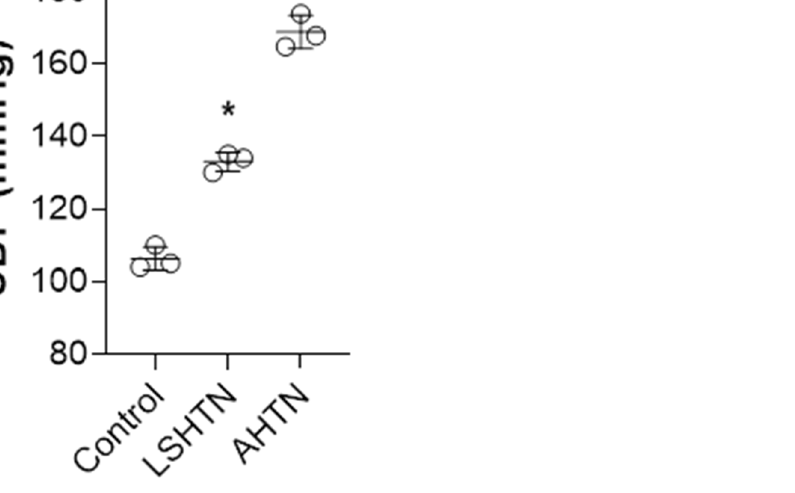
Figure 1. Systemic blood pressures (SBP) of control mice and mice with L-NAME/high-salt-diet- induced hypertension (LSHTN) or angiotensin II induced hypertension (AHTN). * indicates p < 0.05 by ANOVA, ( n = 3).